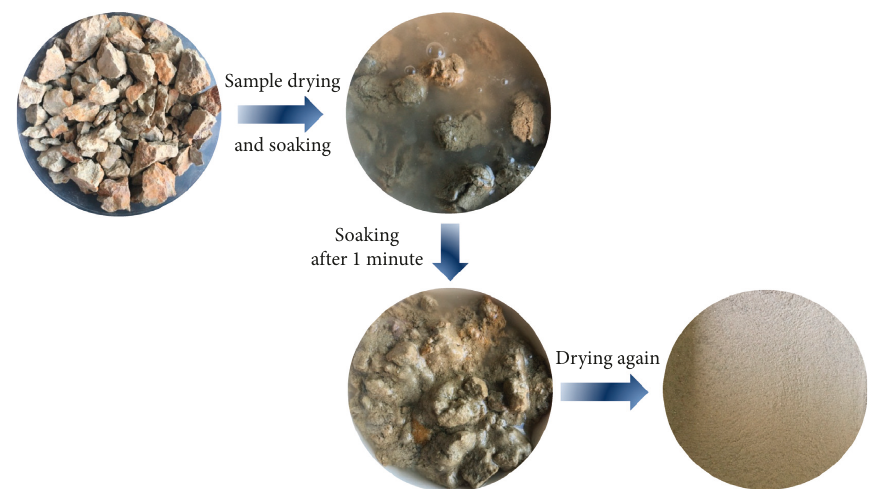
Figure 6: Disintegration and drying of the fault